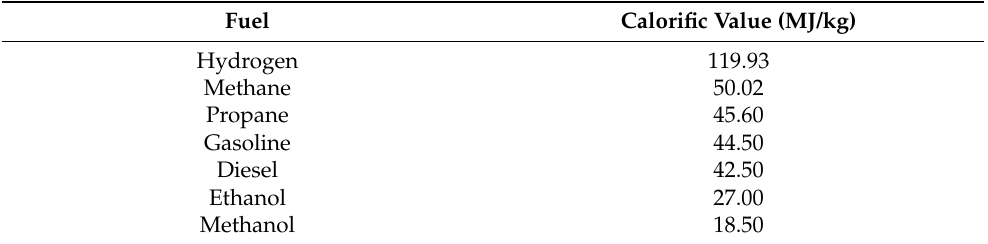
Table 1. Calorific value of different fuels under standard conditions of temperature and pressure.